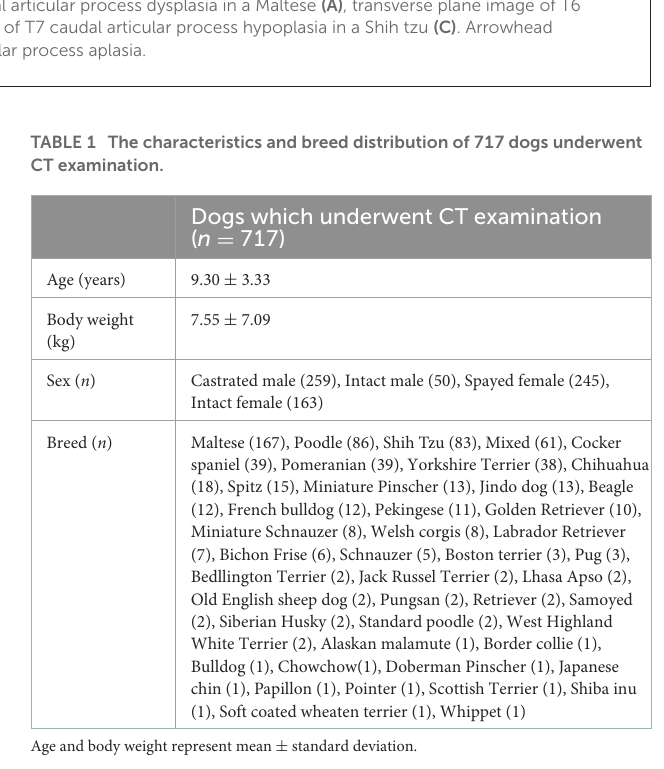
TABLE 2 Prevalence of caudal articular process dysplasia in 717 dogs according to breed types classified by weight.